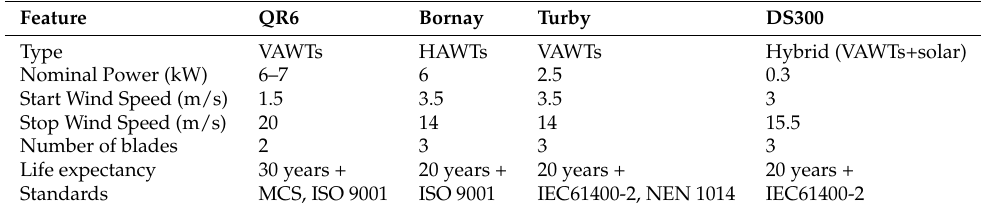
Table 6. Technical details of the selected wind turbines. Data source: [41,57–59]. Feature